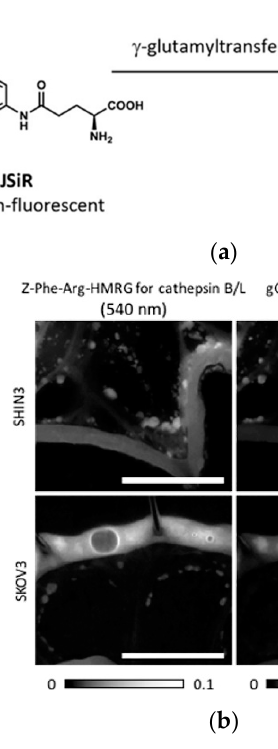
Figure 6. Si-rhodamine near-infrared probe for the detection of GGT: ( a ) Structure of gGlu-HMJSiR and its fluorescent HMJSiR reaction product; ( b ) Ex vivo fluorescence imaging of mouse models with peritoneal metastasis of SHIN3 (top) or SKOV3 (bottom) cells, 60 min after intraperitoneal application of Z-Phe-Arg-HMRG and topical application of gGlu-HMJSiR . Adapted with permission from [120]. Copyright (2018) American Chemical Society. Scale bars = 1 cm.